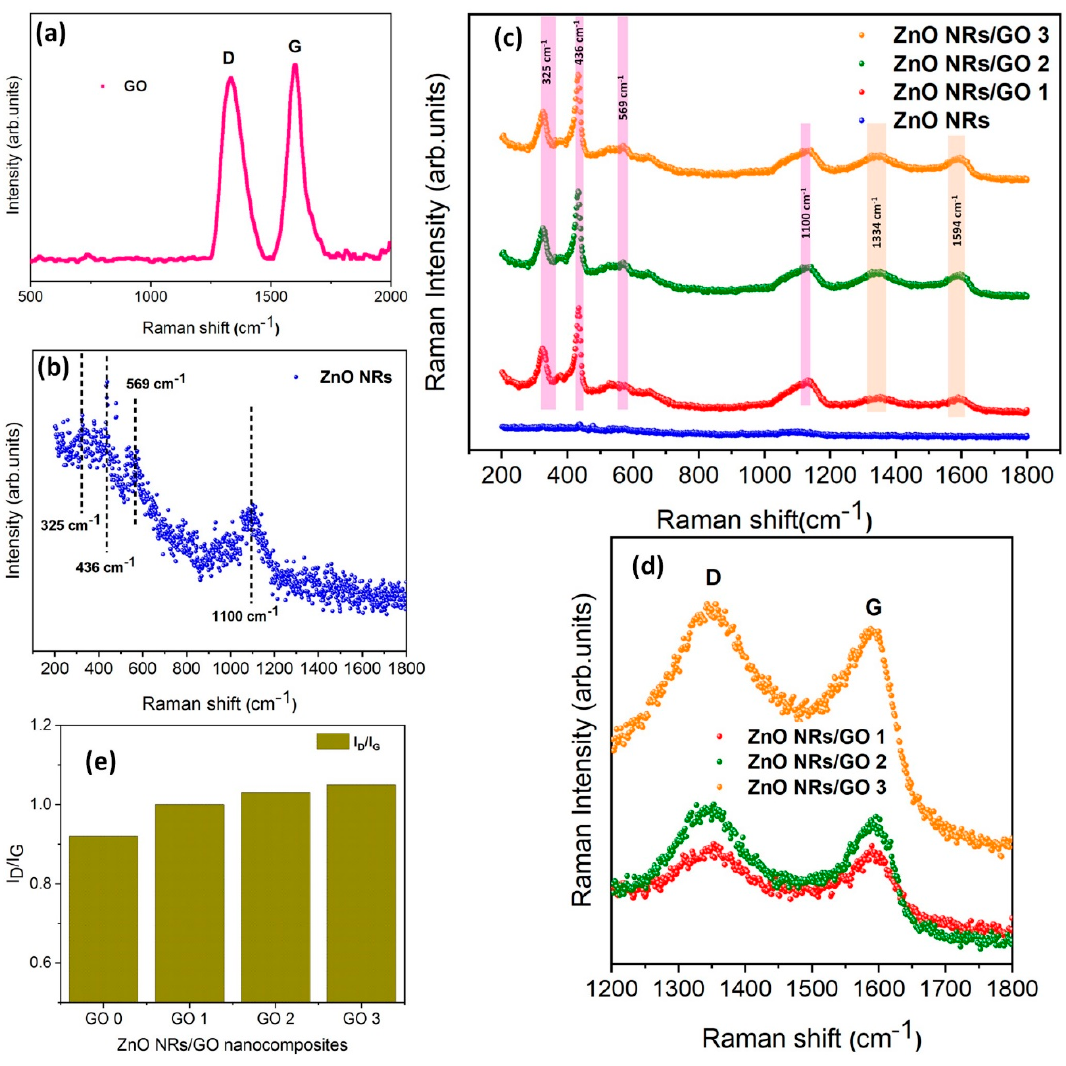
Figure 7. Raman spectra of ( a ) GO, ( b ) ZnO NRs, ( c ) ZnO NRs/GO nanocomposites with different GO concentrations, ( d ) Raman spectra of the same samples shown in the higher region (1200–1800 cm − 1 ), and ( e ) the variation of ( I D / I G ) intensity ratio with GO concentrations.